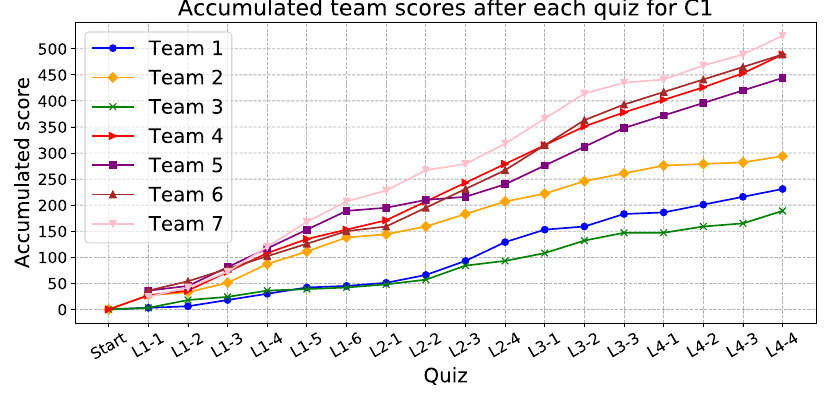
Fig. 3. Development of the accumulated team scores after each quiz for